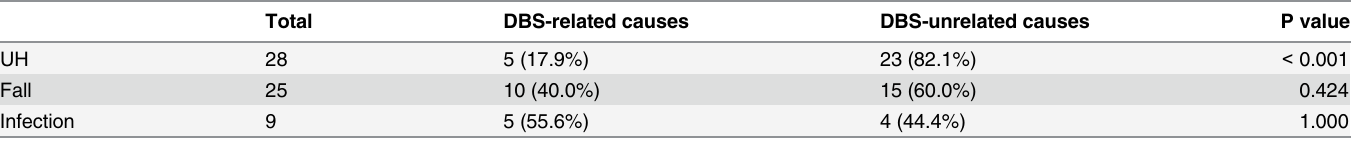
Table 3. Relationship between DBS-related and DBS-unrelated